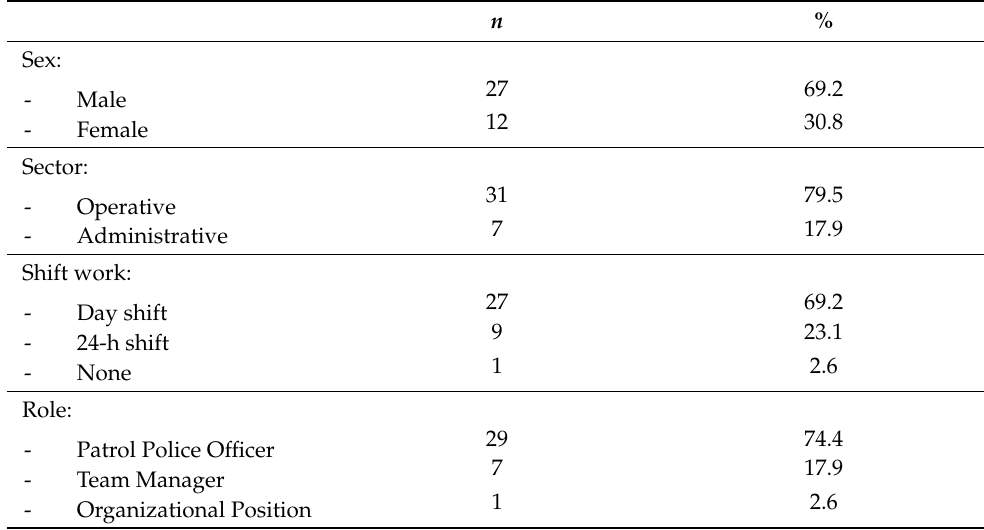
Table 1. Socio-demographic characteristics of the sample ( n =